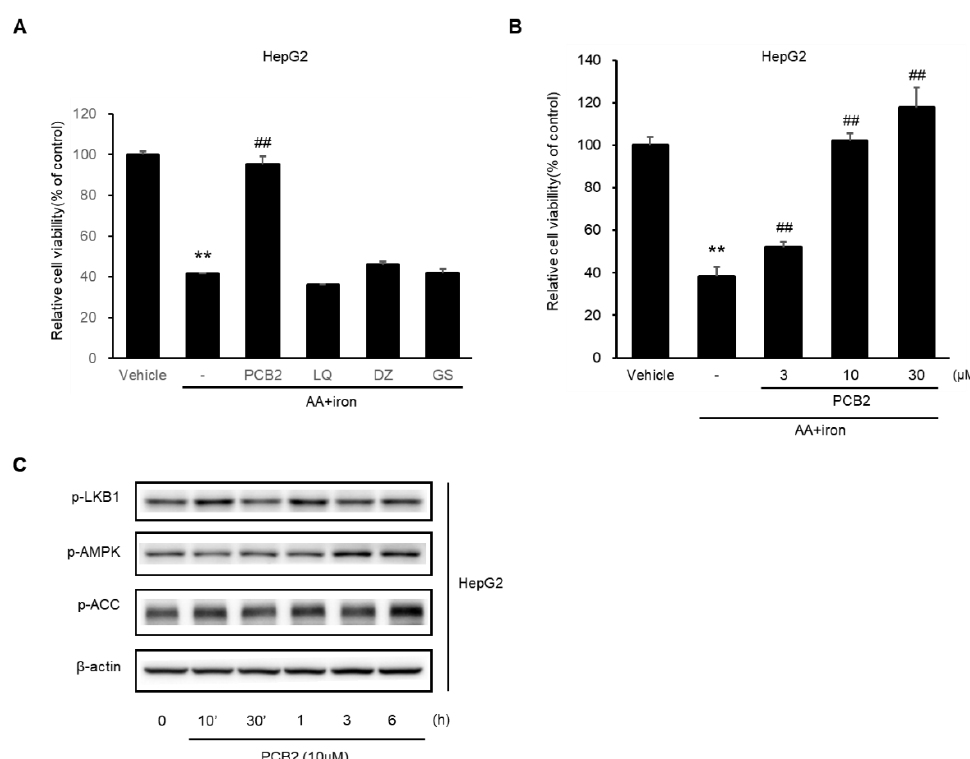
Figure 6. Effects of Procyanidin B2, a representative component of SC. ( A ) HepG2 cells were treated with 10 µ M PCB2, 30 µ M LQ, DZ, and GS for 1 h and then incubated with 10 µ M AA plus some drugs for 12 h, followed by incubation with 5 µ M iron for 6 h. The cell viability was assessed using an MTT assay. ( B ) HepG2 cells were treated with PCB2 (3, 10, 30 µ M) for 1 h, and then proceeded sequentially as described in ( A ). The data represent the mean ± SD (** p < 0.01 between the control and AA + iron-treated cells; ## p < 0.01 between AA + iron and AA + iron-treated cells with compounds). ( C ) Immunoblotting analysis to verify the expression of the AMPK signaling pathway was performed with HepG2 cell lysates. The cells were incubated in serum-free media for 12 h, followed by treatment with 10 µ M PCB2 for the indicated time.